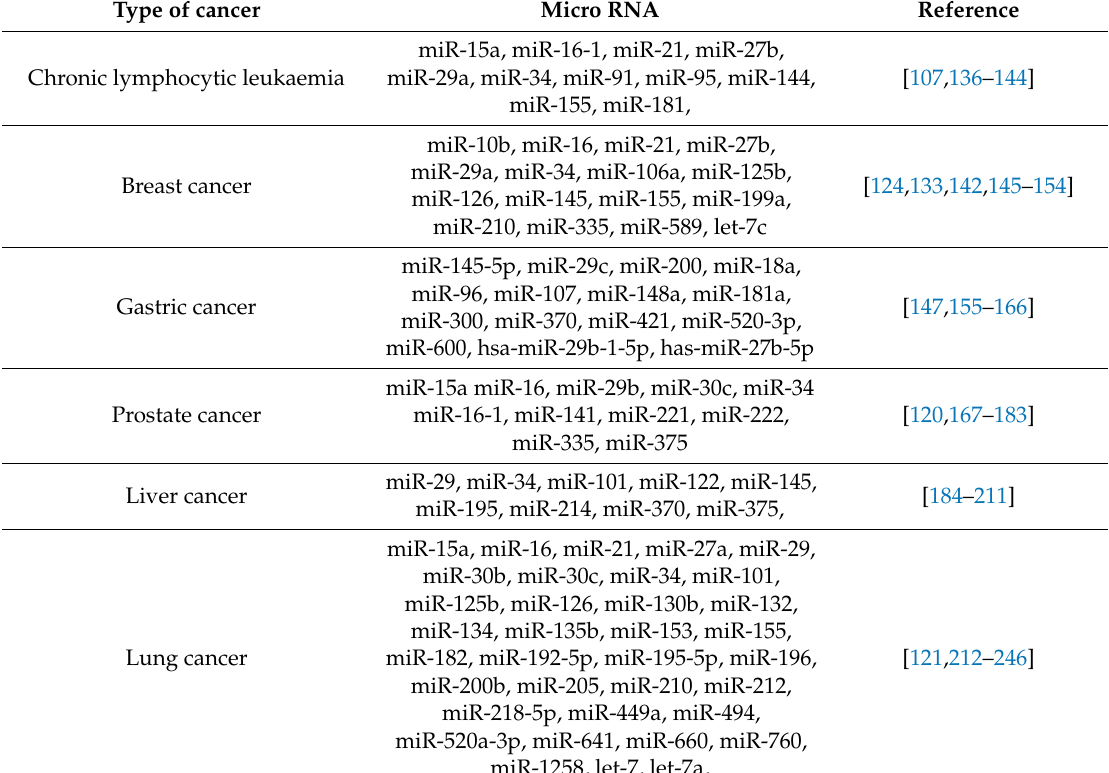
Table 1. Cancers and their association with microRNAs